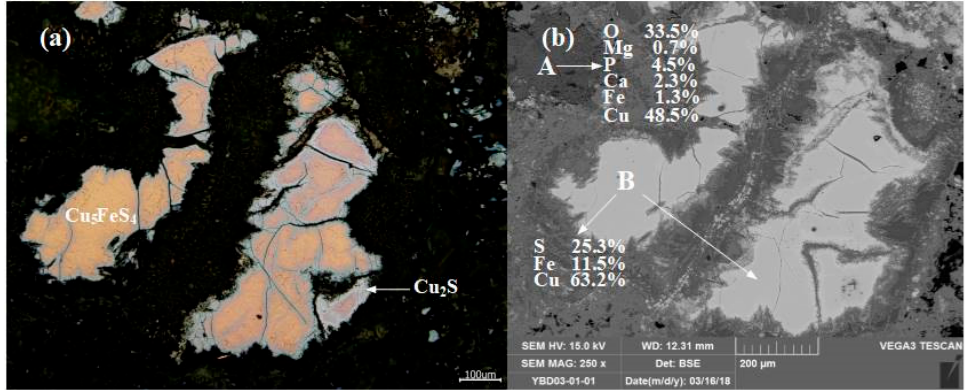
Figure 7. Optical micrograph ( a ) and SEM backscattered electron image ( b ) of YBD03. Sample YBD06: The EDS characterization result showed that the YBD06 sample contains only a trace amount of S. No metallic copper particles were detected under the metallographic microscope, and Cu 2 S (chalcopyrite) appeared as dispersed particles in the copper oxide ore. As shown in Figure 8.